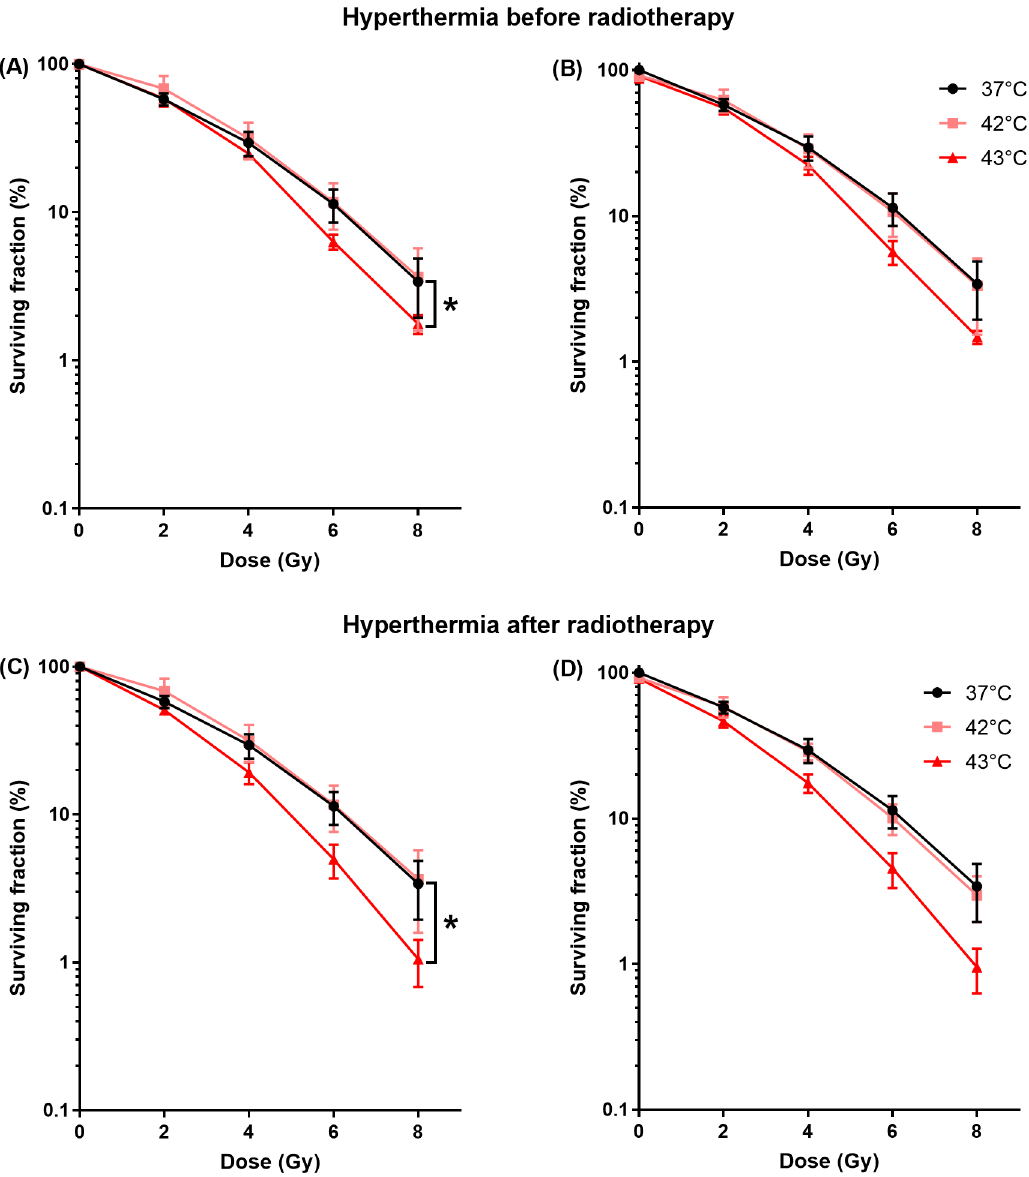
Fig 3. Cytotoxicity of hyperthermia at different temperatures before and after RT. Surviving fraction as function of radiation dose at different temperatures. Cells exposed for 1 hour to 37, 42 or 43˚C before (A and B) or after (C and D) RT normalized for HT treatment at 0 Gy (A and C) and normalized for untreated samples (37˚C and 0 Gy) (B and D). HT of 43˚C resulted in significant enhancement of RT both before (A) and after RT (C). HT of 43˚C resulted in the largest enhancement of the RT.